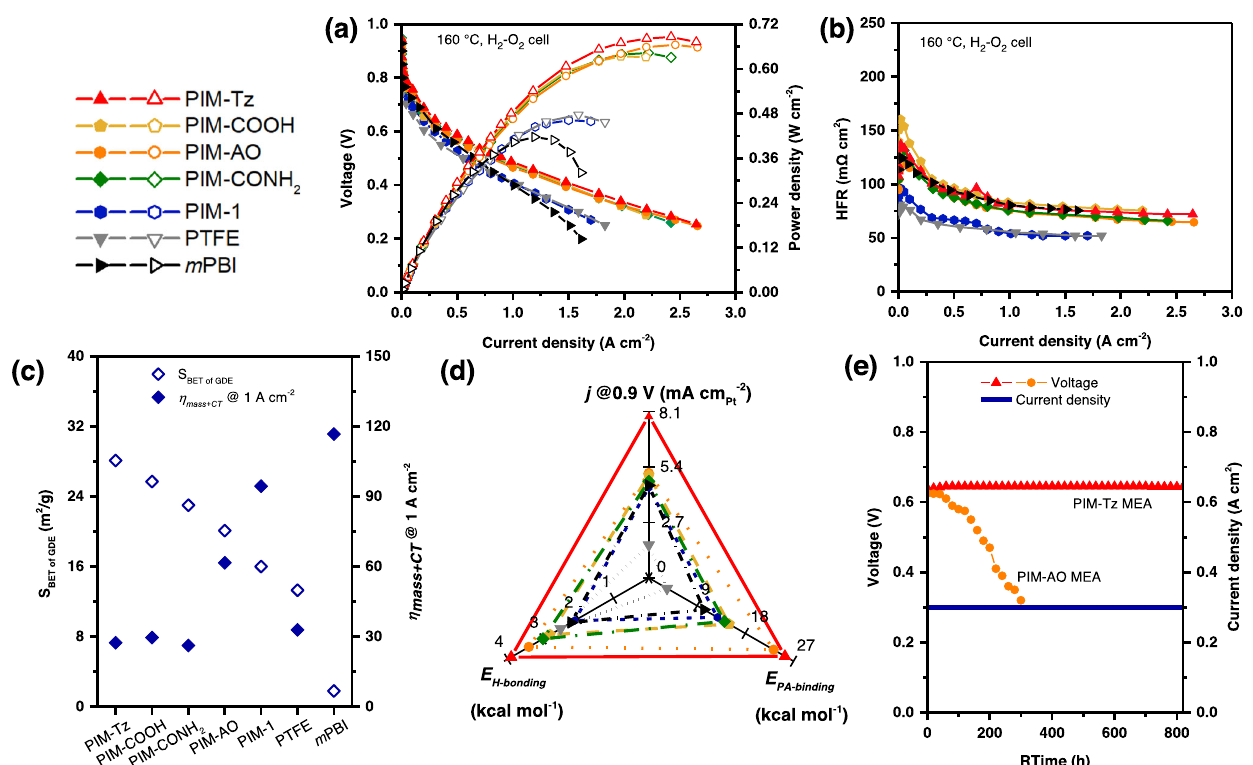
Fig.5|PerformanceoftheMEAswithPIMsbindersinthecatalystlayerwithout backpressure nor external humidi fi cation. a Polarization (solid symbols) and powerdensity(opensymbols)curves, b highfrequencyresistancecurves,and c the relation of the S BET of GDEs with the sum of mass loss and charger transfer loss of